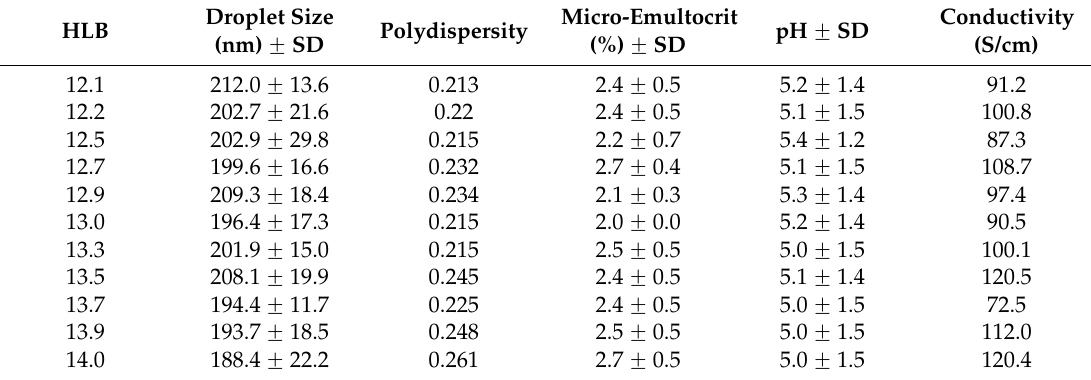
Table 3. Characterization of the second batch of nanoemulsion systems based on bullfrog oil to determine the HLBr after 60 days of evaluation at 25 ˝